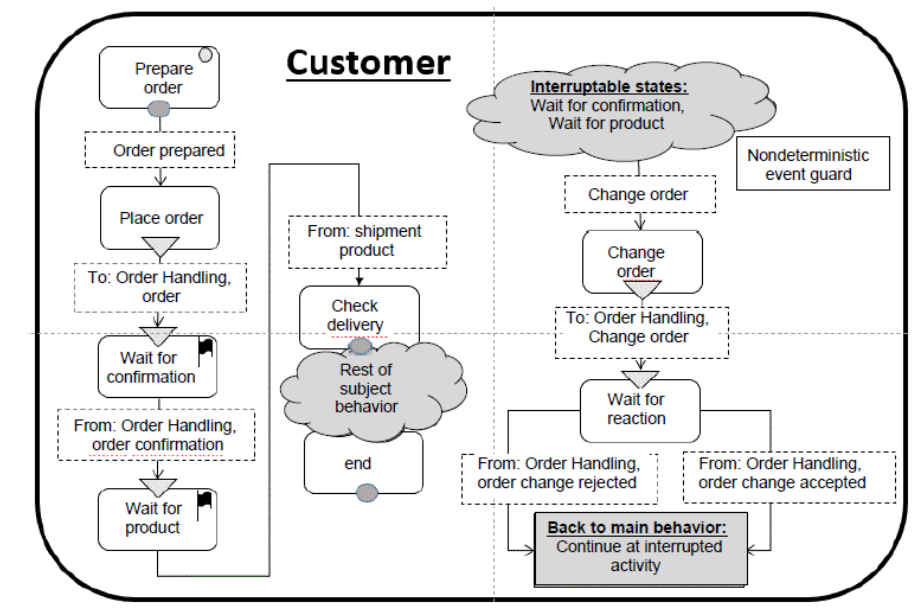
Figure 5. Creating executable process families [53]